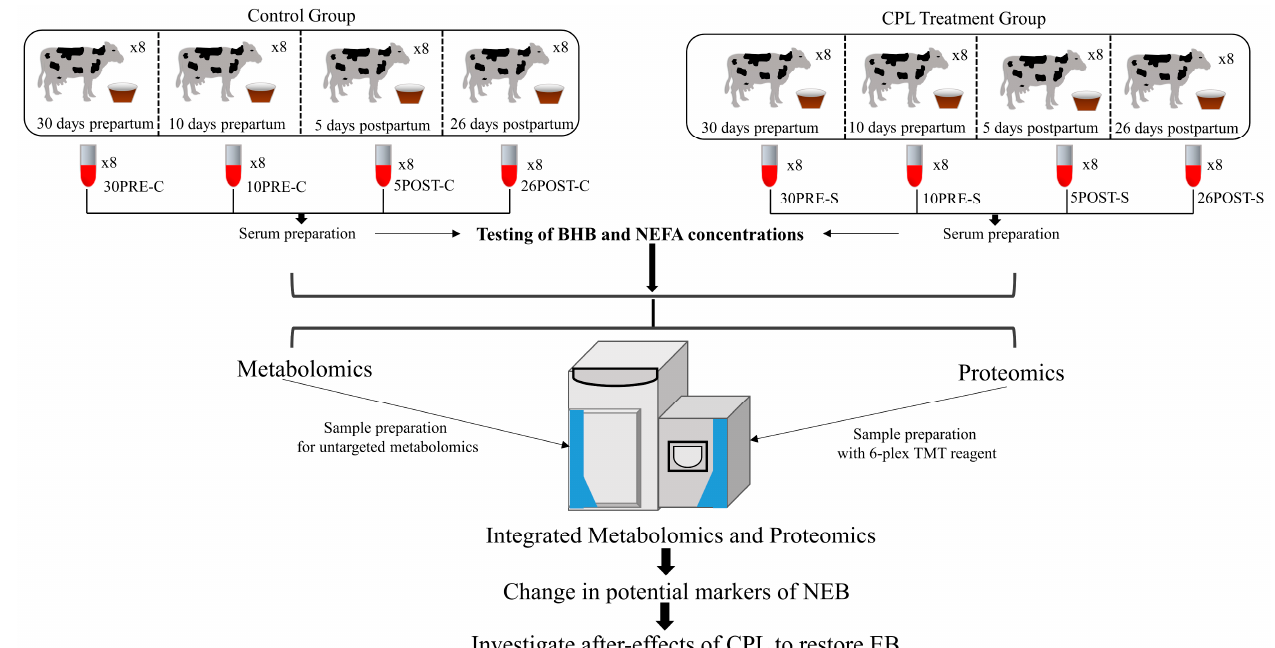
Figure 1. Study workflow. An overview of the procedure used for the identification and quantification of metabolites and proteins in control and CPL-treated groups at 30 and 10 days prepartum and 5 and 26 days